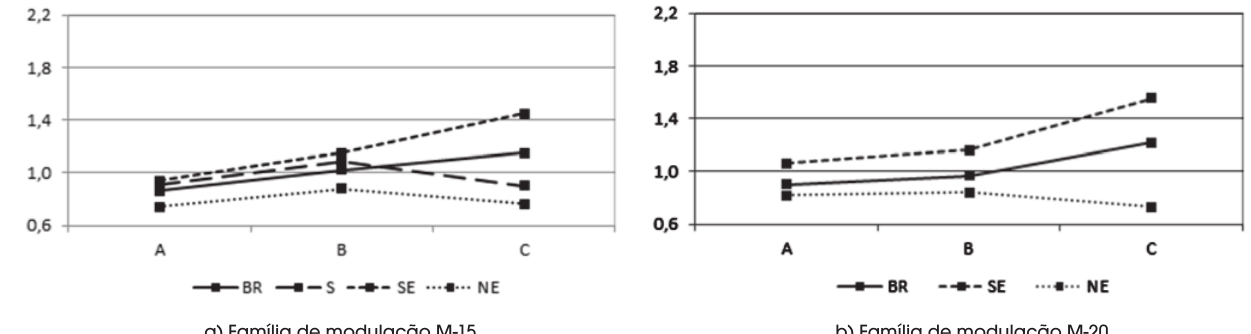
Figura 1 Razão entre a resistência característica estimada e a resistência característica especificada (f em relação às famílias de modulação